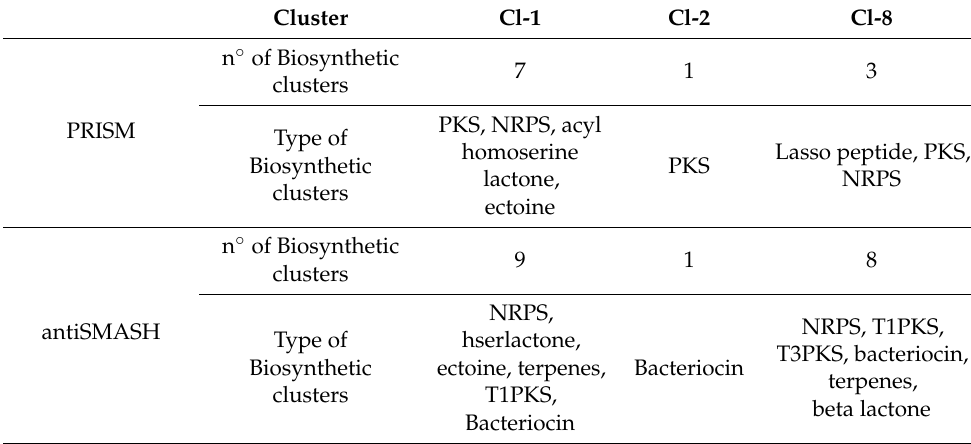
Table 4. Biosynthetic gene clusters identified by PRISM and